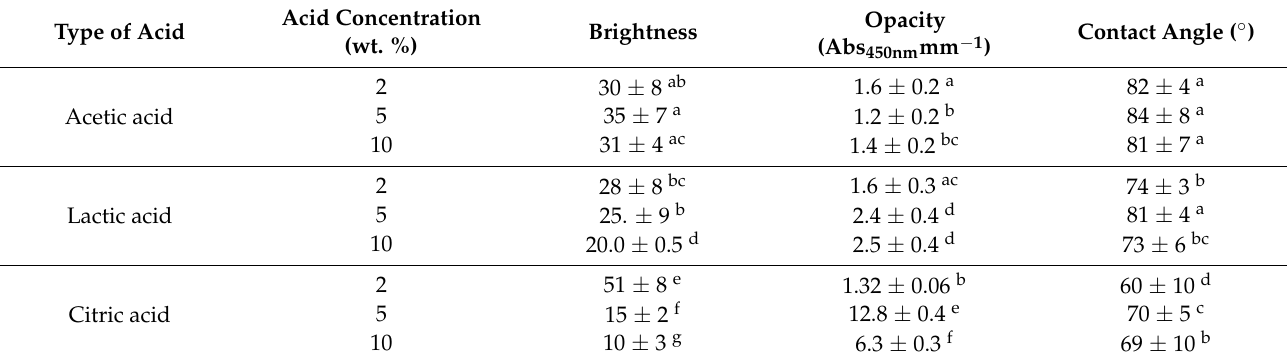
Table 2. Brightness, opacity and contact angle of chitosan films (formed from 1.5% ( w / w ) chitosan solution) with different percentages of acetic, lactic and citric acid.